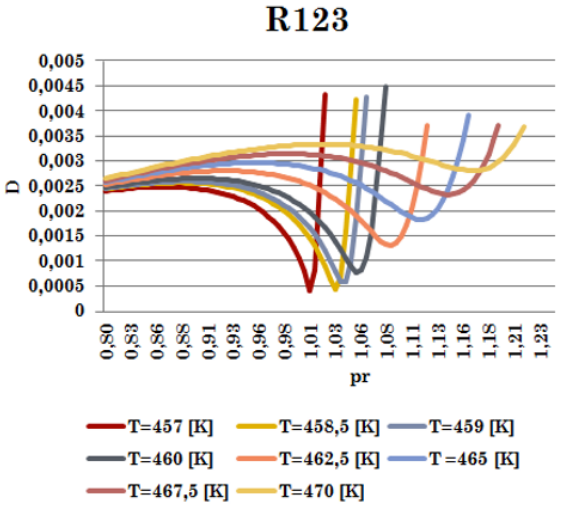
Fig. 4. Reduce thermodynamic stability D of